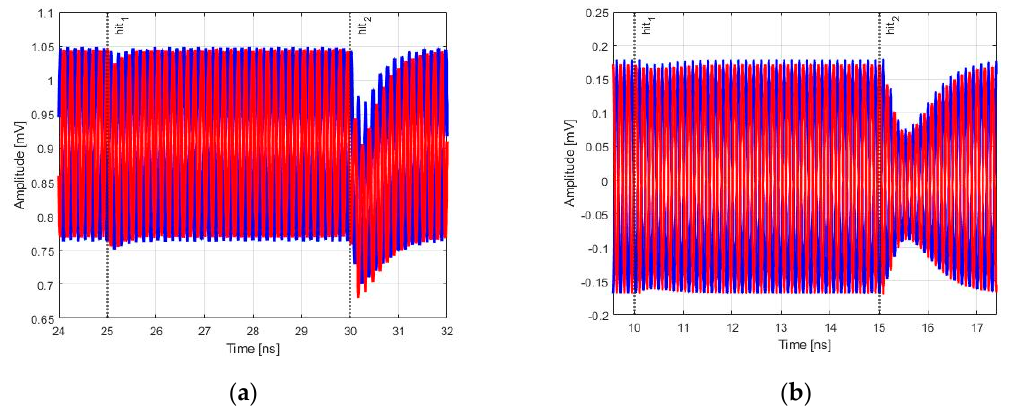
in the RO-VCO, while ( b ) shows the free-running frequency in the LC-VCO.